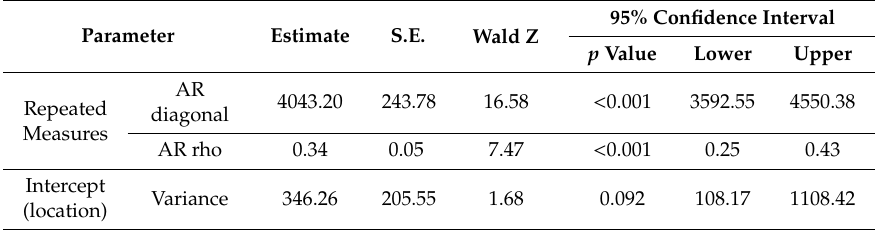
Table A2. Generalized linear mixed model (GLMM) estimates of covariance parameters on the stomatal conductance measured in 147 plants subjected to four treatment classes, grouped by “location” as a random e ff ect with a first-order autoregressive structure (AR), in the experimental plot during the irrigation period (summer